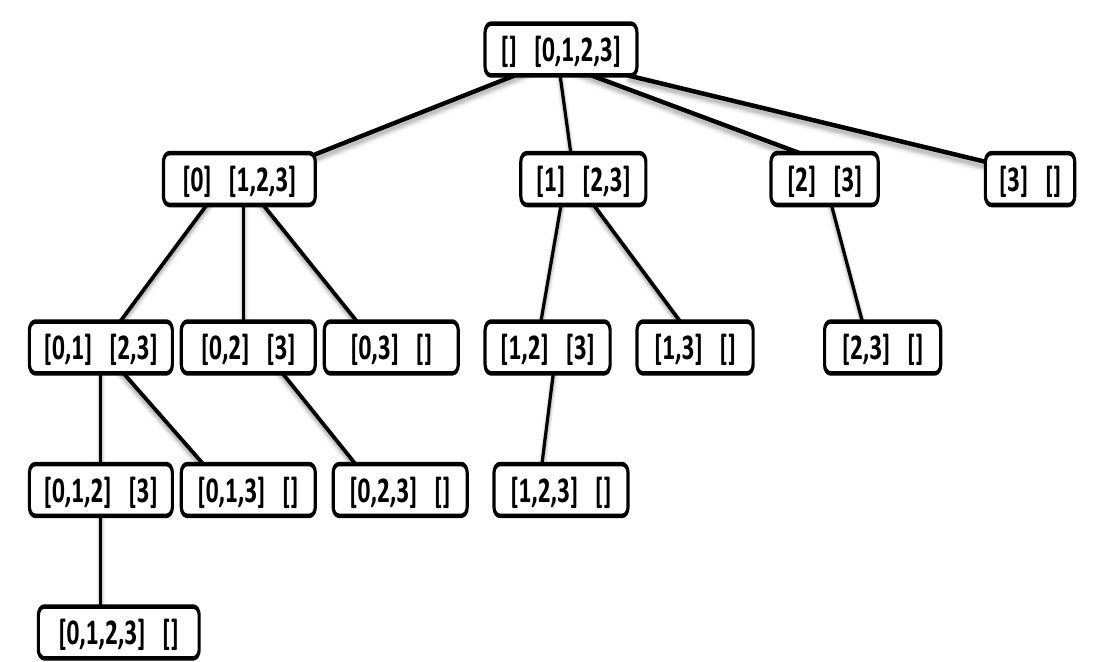
Figure 2. A binomial search tree producing the power set of { 0 , 1 , 2 , 3 }